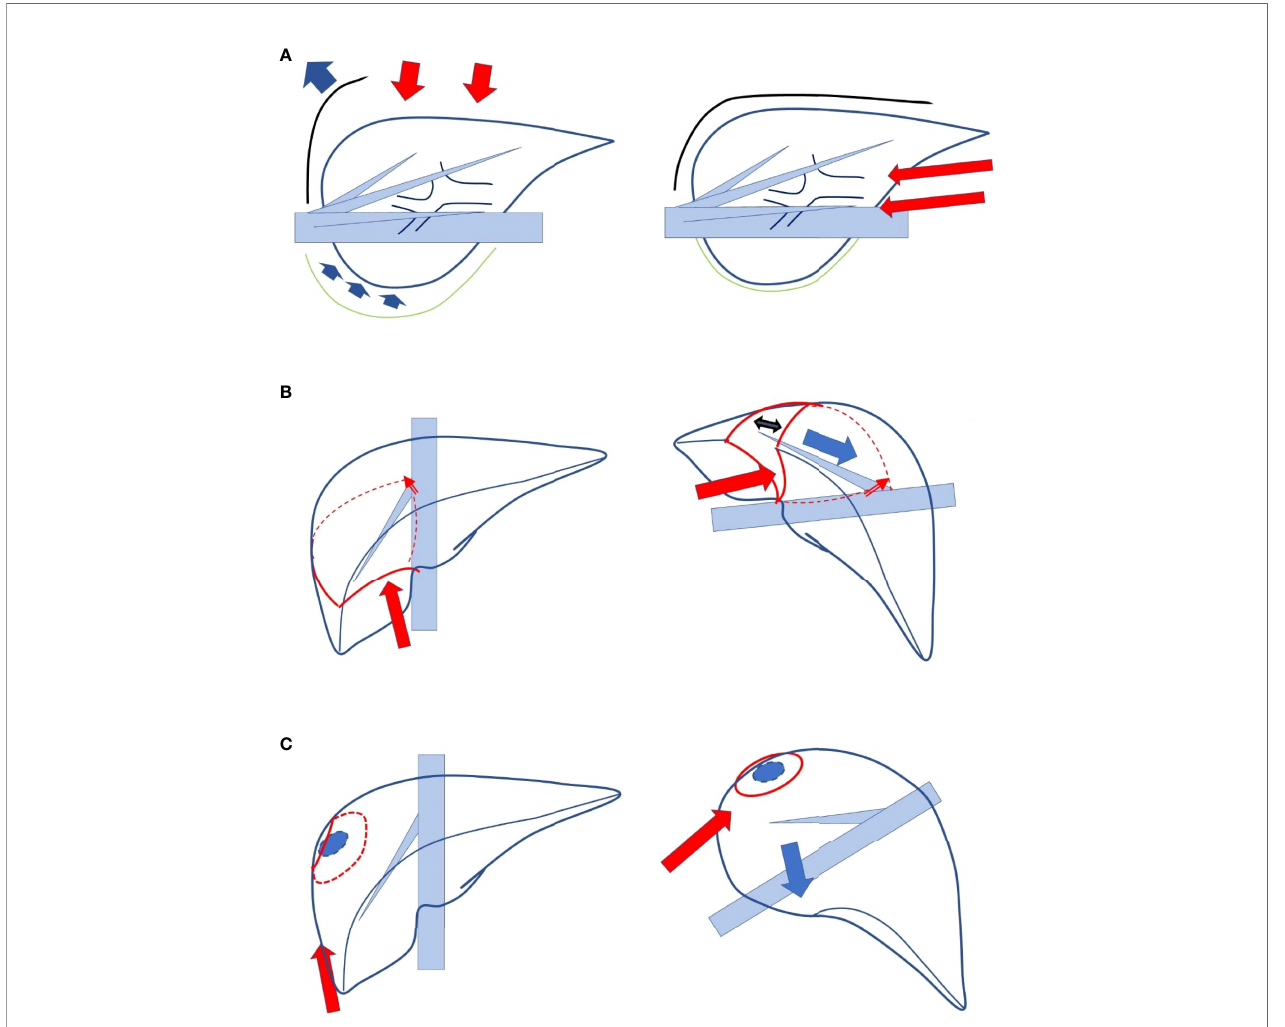
FIGURE 1 | (A) Liverresectionisaprocedureinwhichtheliver protectedinside thesubphrenic “ ribcage ” ishandledandresected. Inopenliver resection,thecage isopened withthe bigsubcostalincisionfollowedbyliftingthe costalarch, andthemobilizedliverispickedupfrom theretroperitoneum (left,lateralview). Inalaparoscopicprocedure, laparoscopeandforcepsintrudeintothecagedirectlyfromcaudaldirectionwithoutdestructionofthecageandwithminimummobilizationoftheliver (right,lateralview). (B) The boundaryplanebetweenthe anterior andposteriorsections, thecuttingplaneofposteriorsectionectomy,ishorizontalandthelargeheavyliver andgravityobstructexposureof theplaneinsupineposition(left).Intheleftlateralpositionwithtransectionprior tomobilization, the cutting planebetweentheretroperitoneal- fi xedresectedliverandthesunk remnantliver iswell-opened(right). (C) Thetransectionofsegmentectomyor partialresectioninsegment7 oftheliver shouldbeperformedinthe deepsmallsubphrenicspace withsegment6 asanobstacleinthewaytothelesions. Inasemi-proneposition, directaccess tosegment7canbeobtainedwiththe eliminationofsegment6inthedownward